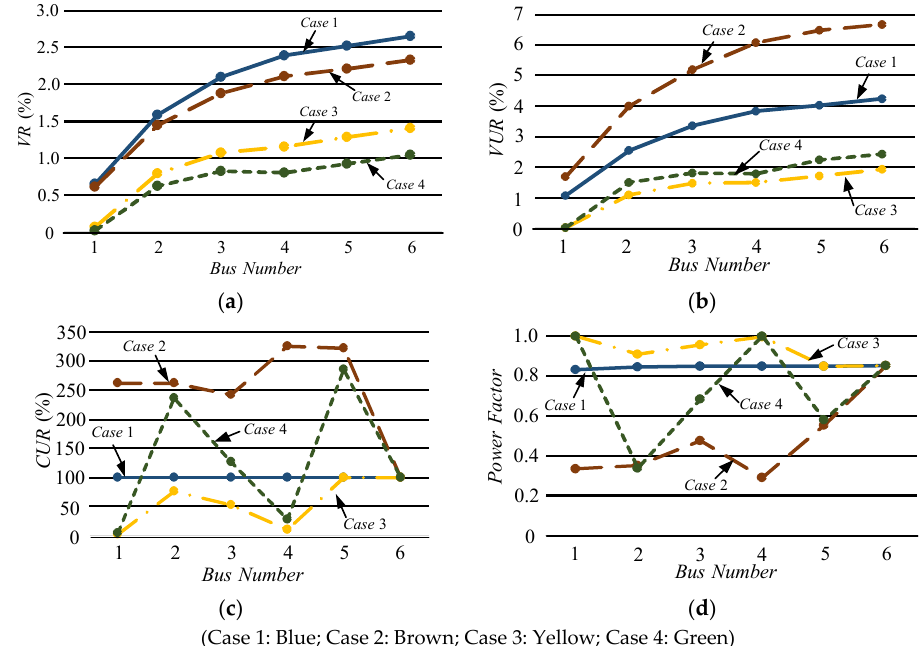
Figure 12. Comparison of all cases. ( a ) Voltage regulation; ( b ) voltage unbalance ratio; ( c ) current unbalance ratio; ( d ) power factor.